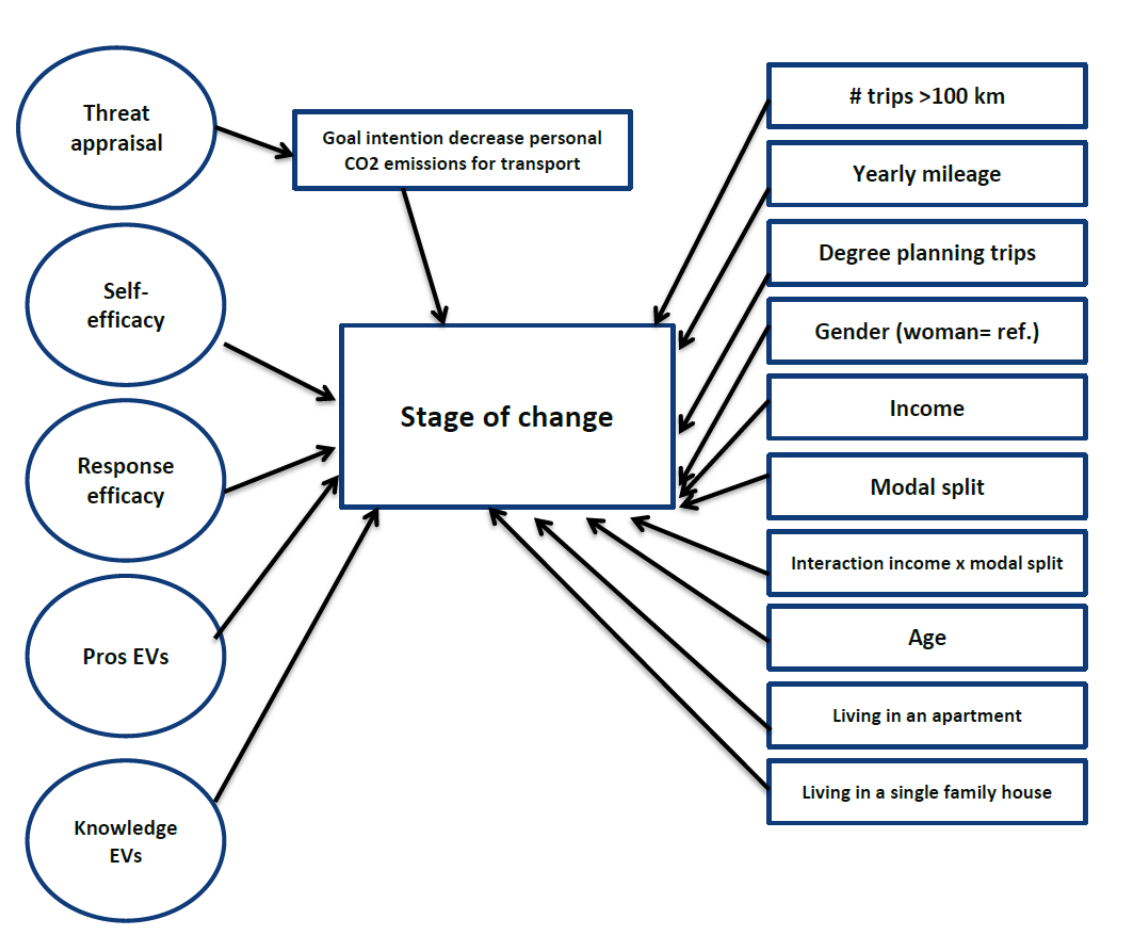
Figure 4. Diagram SEM